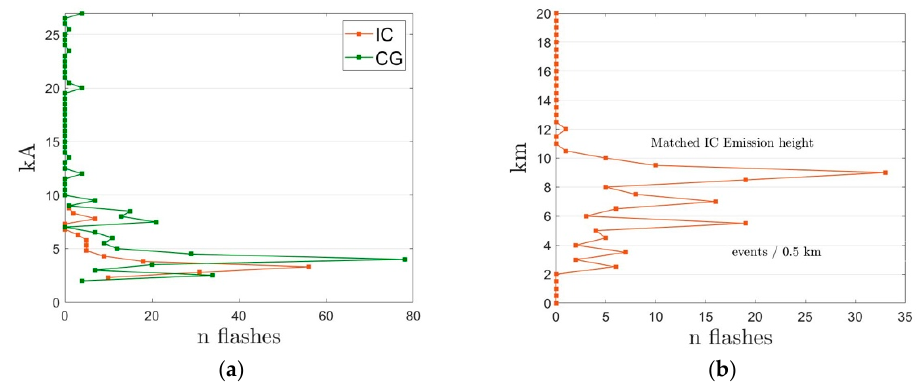
Figure 10. ( a ) LINET IC matched lightning amplitude distribution in the Mt. Cimone area divided into CG and IC data in steps of 0.5 kA. Area considered: 100 km radius around the observatory. Data range: January–December 2020; ( b ) LINET IC matched emission height (steps/0.5 km). Area considered: 100 km radius around the Mt. Cimone Observatory. Data range: January–December